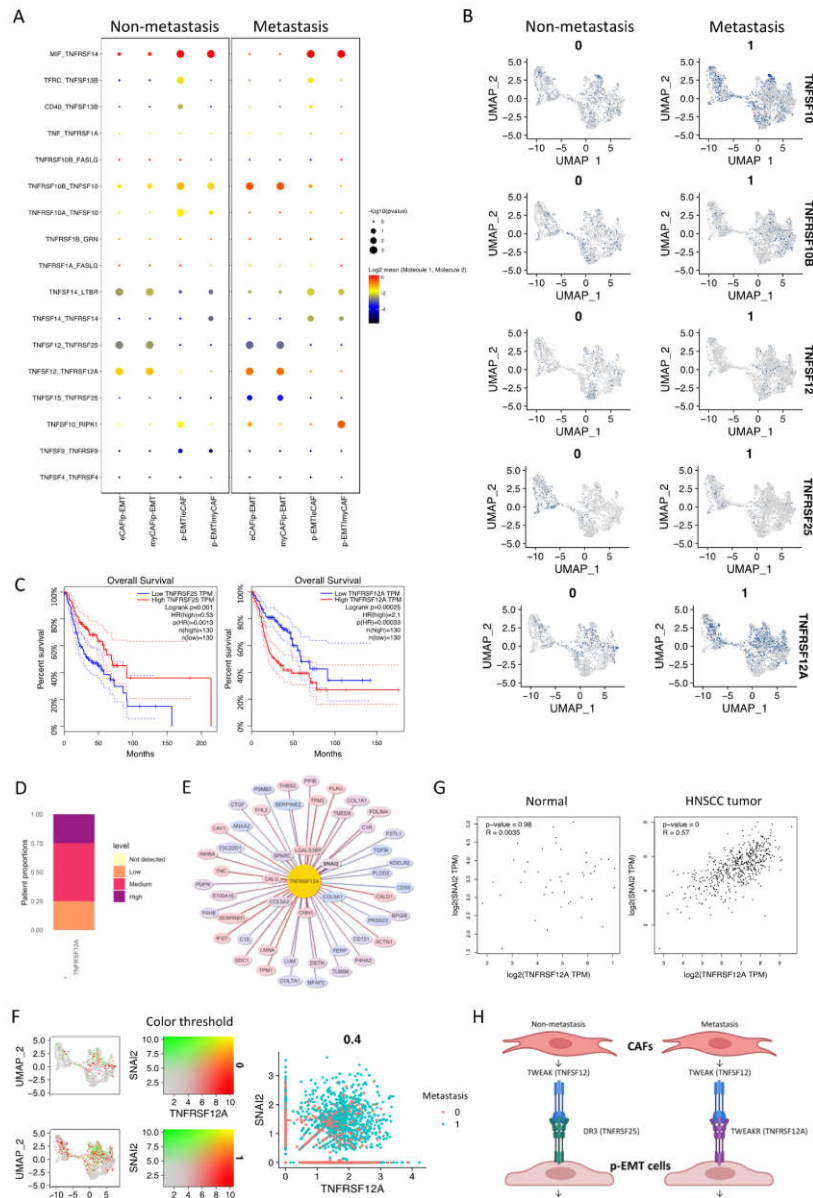
Figure 5. Different roles of TNFRSF25 and TNFRSF12A in non- and metastasis conditions of oral cancer. ( A ) Significant TNF signaling pathway communications were altered in non- vs. metastasis conditions between p-EMT and eCAF/myCAF clusters. ( B ) TNF signaling pathway-related gene expression in integrated single-cell RNA-seq of fibroblasts and epithelial cells in non- vs. metastasis conditions. ( C ) Survival plots of head and neck cancer patients with high TNFRSF25 (left panel) and TNFRSF12A (right panel) expression from TCGA database. ( D ) Proportion of TNFRSF12A expression in head and neck cancer patients from Human Protein Atlas. ( E ) Top 100 TNFRSF12A-correlated genes in integrated single-cell RNA-seq of fibroblasts and epithelial cells. ( F ) Co-expression (left) and scatter (right) plots of TNFRSF12A (red) and SNAI2 (green) in integrated single-cell RNA-seq of fibroblasts and epithelial cells in non- (0) vs. metastasis (1) conditions. ( G ) Correlation plots of TNFRSF12A and SNAI2 gene expressions in HNSCC non-tumor samples (normal cells) and tumor tissues from TCGA database. ( H ) Conceptual diagram (visualized by BiorRender) of p-EMT cells and CAFs communication in non- vs. metastasis oral squamous cell carcinomas via TWEAK (TNFSF12)-DR3 (TNFRSF25)/TWEAKR